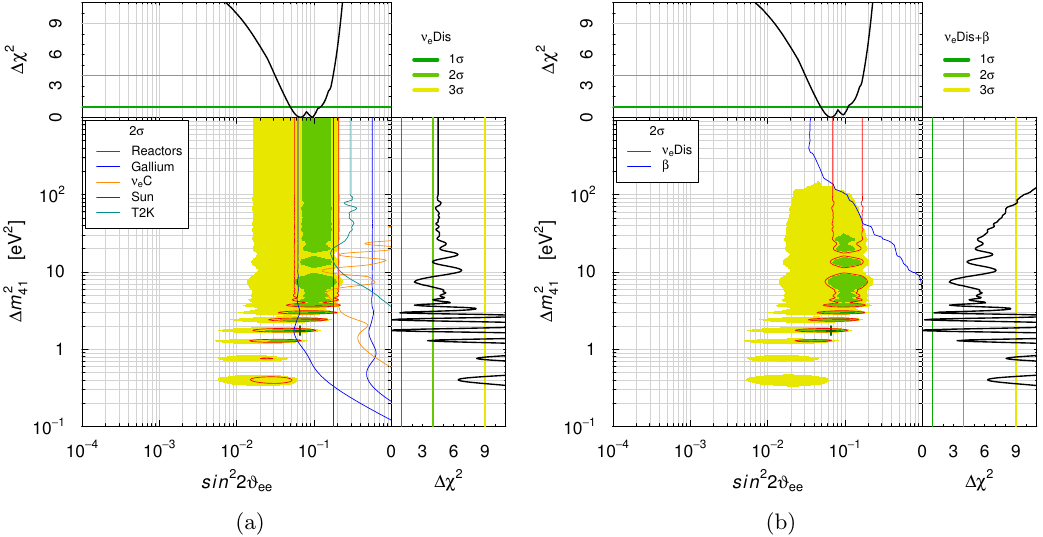
Figure 5 . Allowed regions in the sin 2 2 # ee {(cid:1) m 2